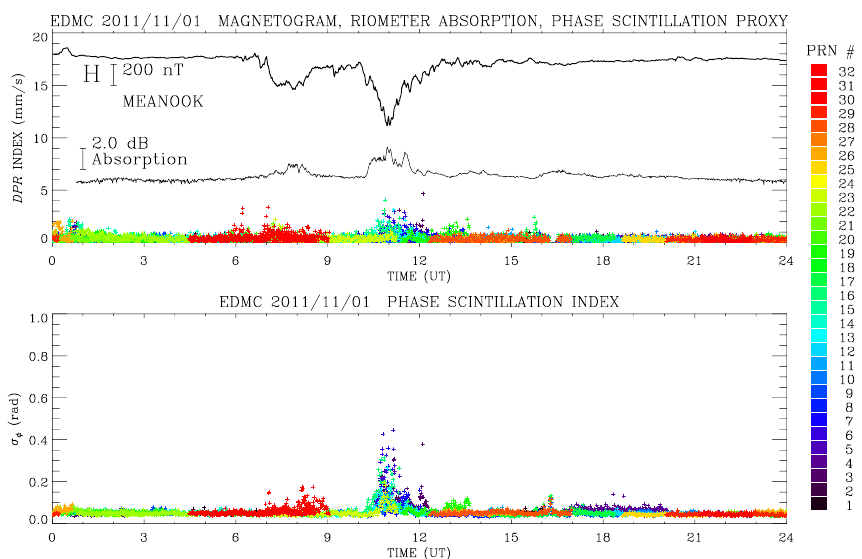
Fig. 11. The proxy DPR index and phase scintillation σ 8 index obtained for elevations above 30 ◦ from GPS receiver in Ministik Lake (EDMC) on 1 November 2011. Superposed in the top panel are the riometer absorption and the H component of the ground magnetic field measured at Meanook.